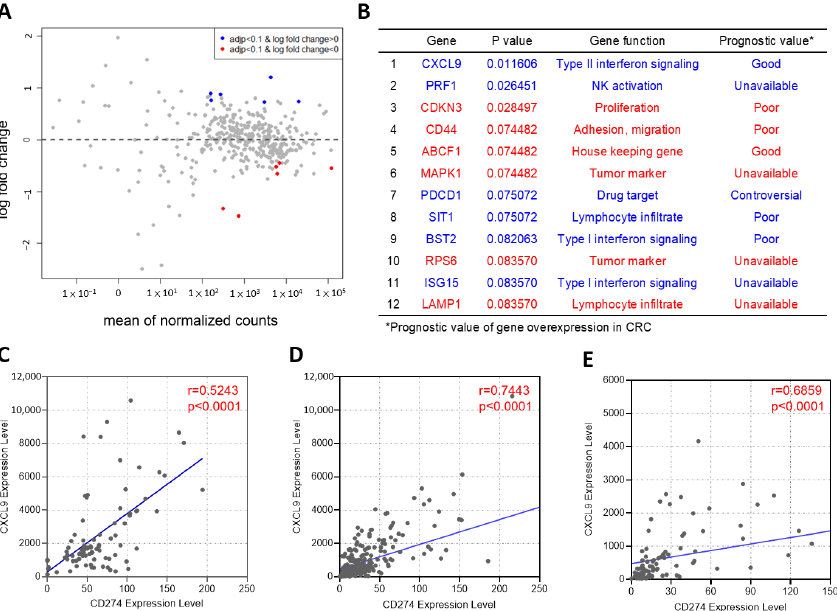
Figure 4. Immune response genes differentially expressed between CRCs with high and low PD-L1 expressions. ( A ) The MA plot shows the log-fold change against the average expression levels of 395 immune-related genes between CRCs with high (CPS ≥ 5) and low PD-L1 expression (CPS < 5). The y-axis represents the log2 fold of change for each gene and the x-axis represents the mean value of normalized reads. Points in red and blue indicate genes with significantly higher and lower expression levels in CRCs with high PD-L1 expression (adjusted p < 0.1). ( B ) The list of differentially expressed genes with statistical significance ( p < 0.1) between the groups of high and low PD-L1 expressions, and the prognostic value of those genes in CRC [7,18–32]. Genes in red and blue indicate genes with significantly higher and lower expression levels in CRCs with high PD-L1 expression (adjusted p < 0.1). The correlation between CD274 and CXCL9 was analyzed using the Spearman correlation coefficient in CRCs from NCKUH ( C ), and the colon ( D ) and rectal cancer ( E ) cohort from the TCGA PanCancer Atlas. r, Spearman’s rank correlation coefficient.